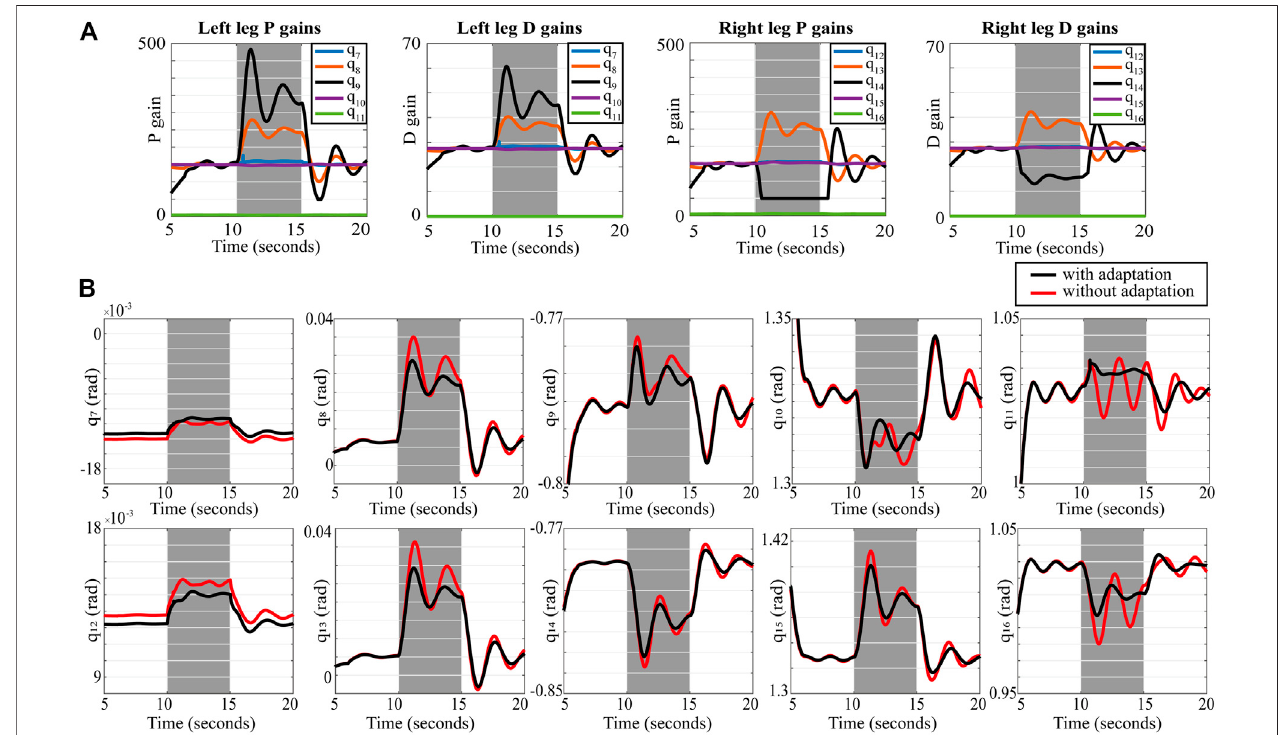
FIGURE 4 | Simulation results of pushing the pelvis: (A) The adapted gains of the WBLC in the joint level. (B) The con fi guration of the robot controlled by WBLC.